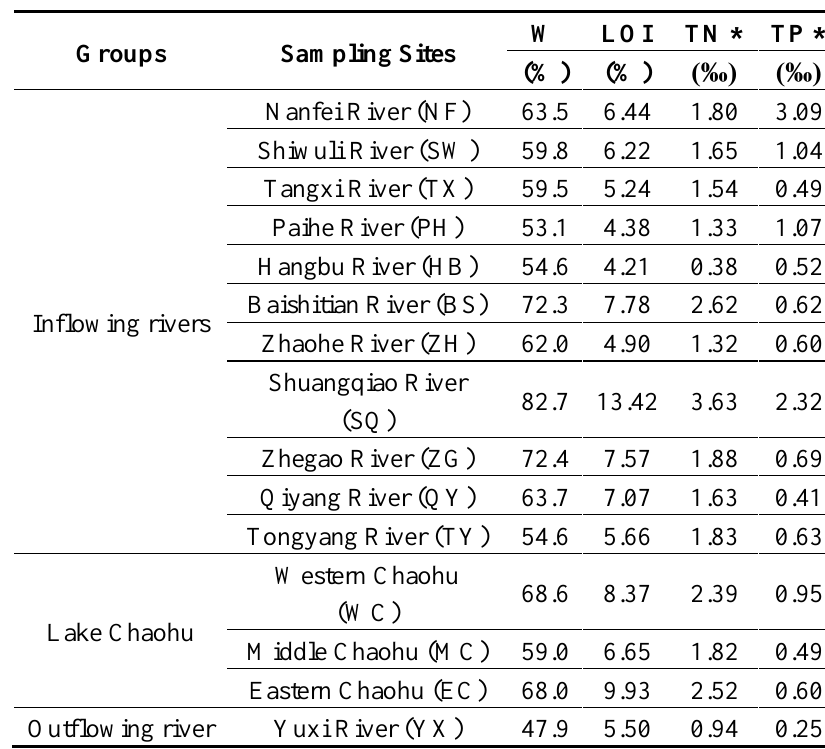
Table 2. Water content (W), loss on ignition (LOI), total nitrogen (TN), and total phosphorus (TP) of sediment